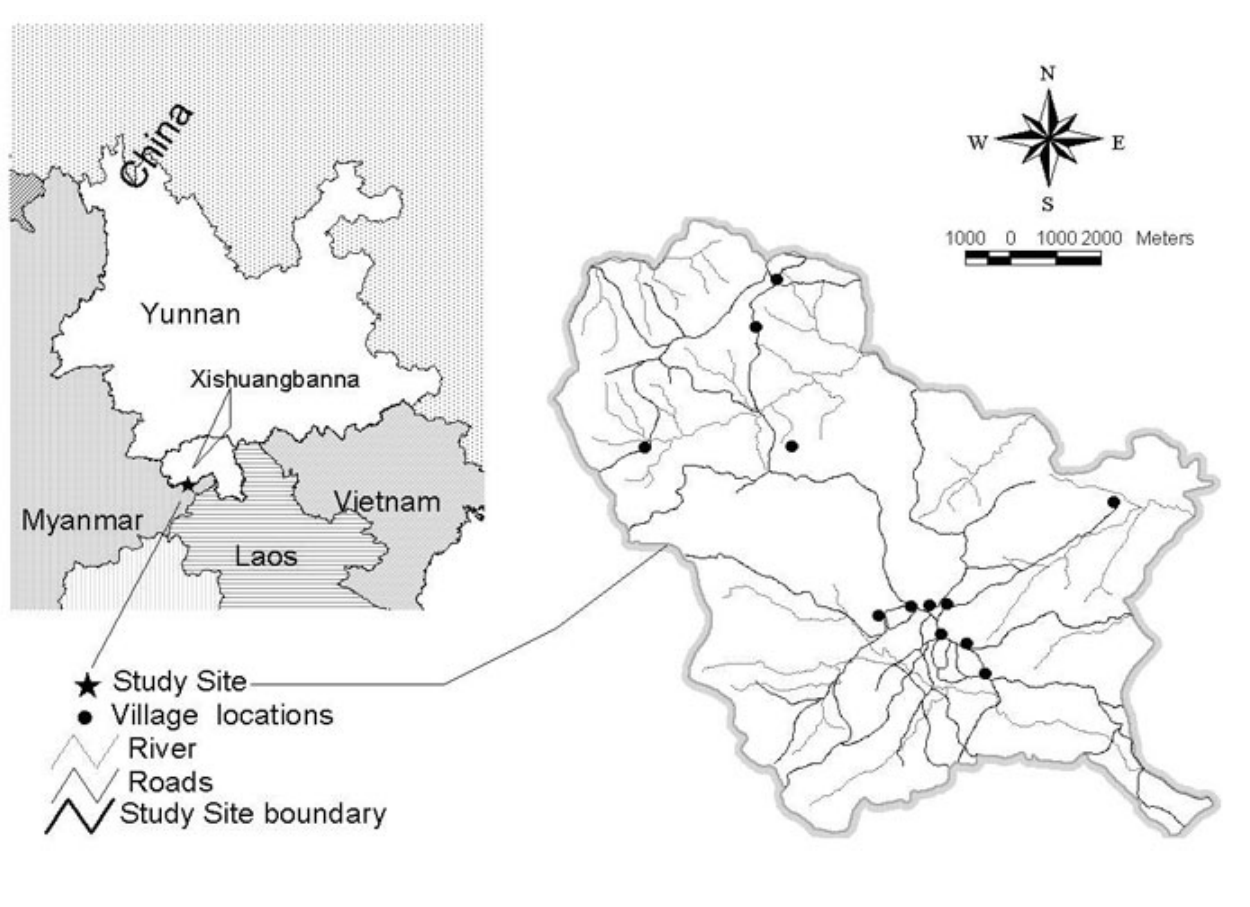
Figure 1. Map of the Mengsong region in Yunnan Province, southwest